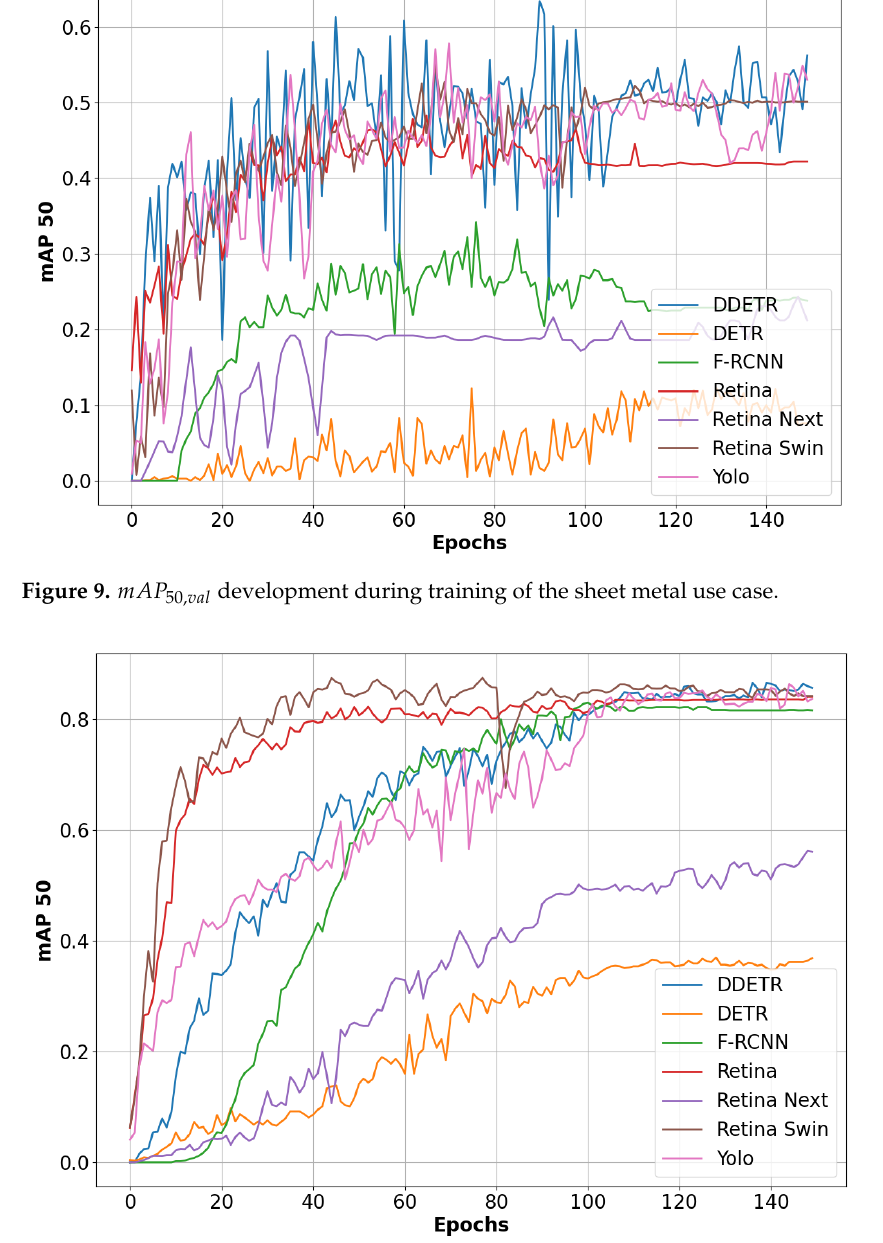
Figure 10. mAP 50, val development during training of the wooden load space use